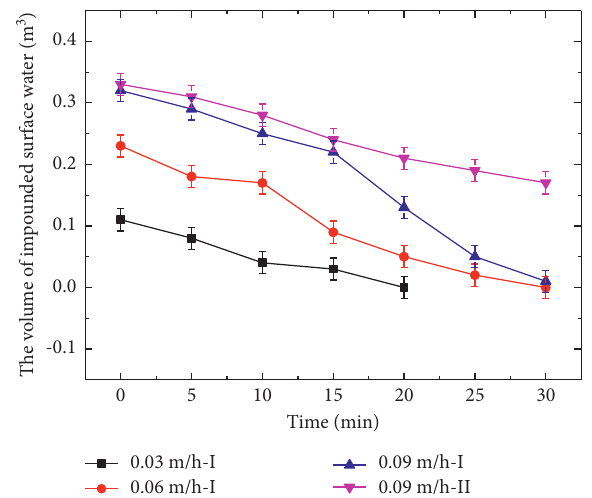
Figure 9: Time history curve of impounded surface water in the artificially simulated rainfall experiment (the time of 0min is to indicate that the rainfall has just stopped. When there is no impounded surface water, the volume of impounded surface water is 0m 3 . The error bar means the root mean square error of the volume of impounded surface water.).